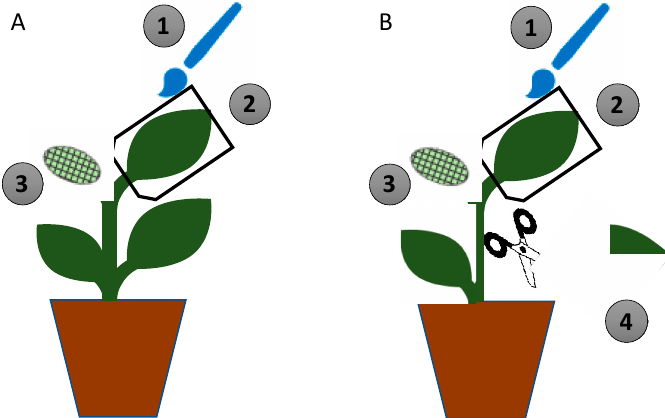
Figure 1. Design of the in-planta experiment. ( A ) Non-damaged plant; ( B ) damaged plant. (1) One leaf was brushed with the fungal suspension (treated) or sterile water with 0.1% Tween 80 (control). (2) The leaf was covered with a transparent plastic bag for 48 h. (3) Four L 2 Spodoptera littoralis larvae were clipped on a non-treated leaf at 48 h and left to feed on the leaf for 48 h. (4) Damage was artificially caused by tearing a non-treated leaf at 48 h after fungal inoculation.